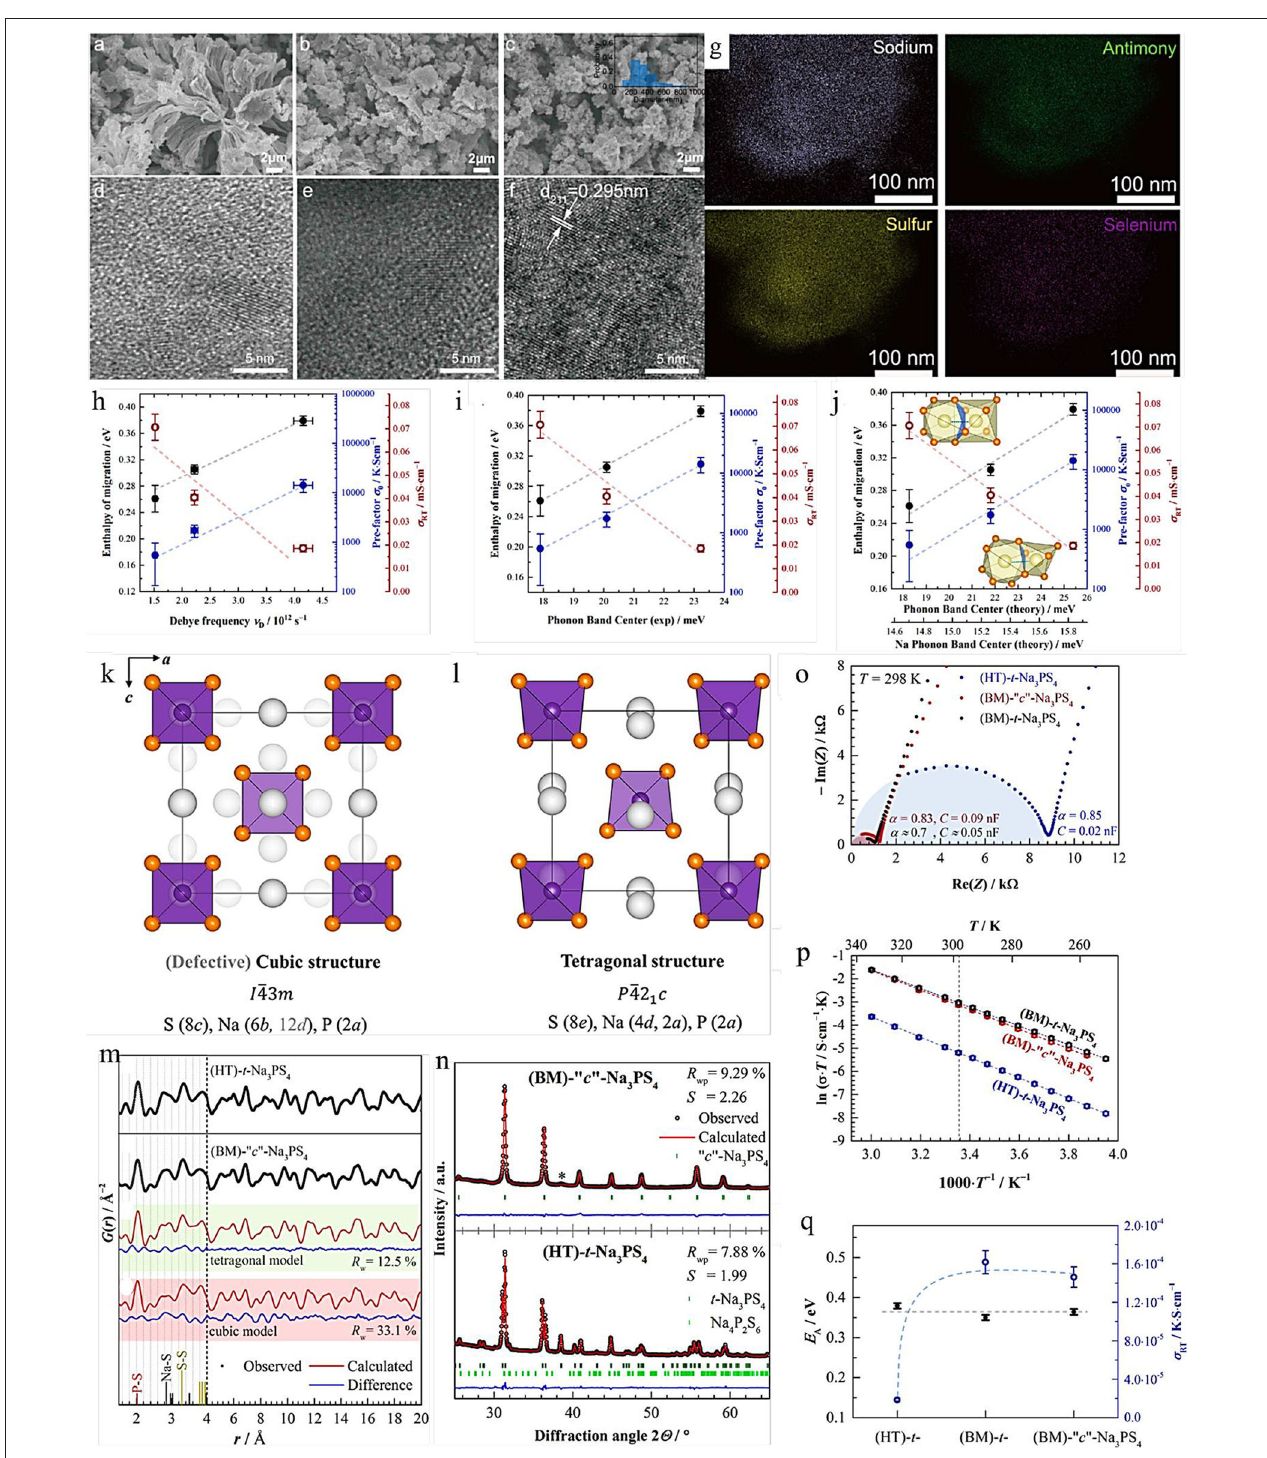
FIGURE 1 | SEM images of Na 3 SbS 3.75 Se 0.25 electrolytes synthesized by (a) liquid-phase method, (b) solid-phase method, and (c) liquid/solid fusion technology (the inset is the statistical particle size distribution of the electrolytes). HRTEM images of Na 3 SbS 3.75 Se 0.25 electrolytes synthesized by (d) liquid-phase method, (e) solid-phase method, and (f) liquid/solid fusion technology. (g) STEM images of Na 3 SbS 3.75 Se 0.25 electrolytes synthesized liquid/solid fusion technology (source Wan et al., 2019). Reproduced by permission of Elsevier B.V. https://doi.org/10.1016/j.nanoen.2019.104109. Correlation between measured enthalpy of migration E A and prefatory σ 0 and (h) the measured Debye frequency, (i) the measured (total) phonon band center, and (j) the computed total and Na-projected